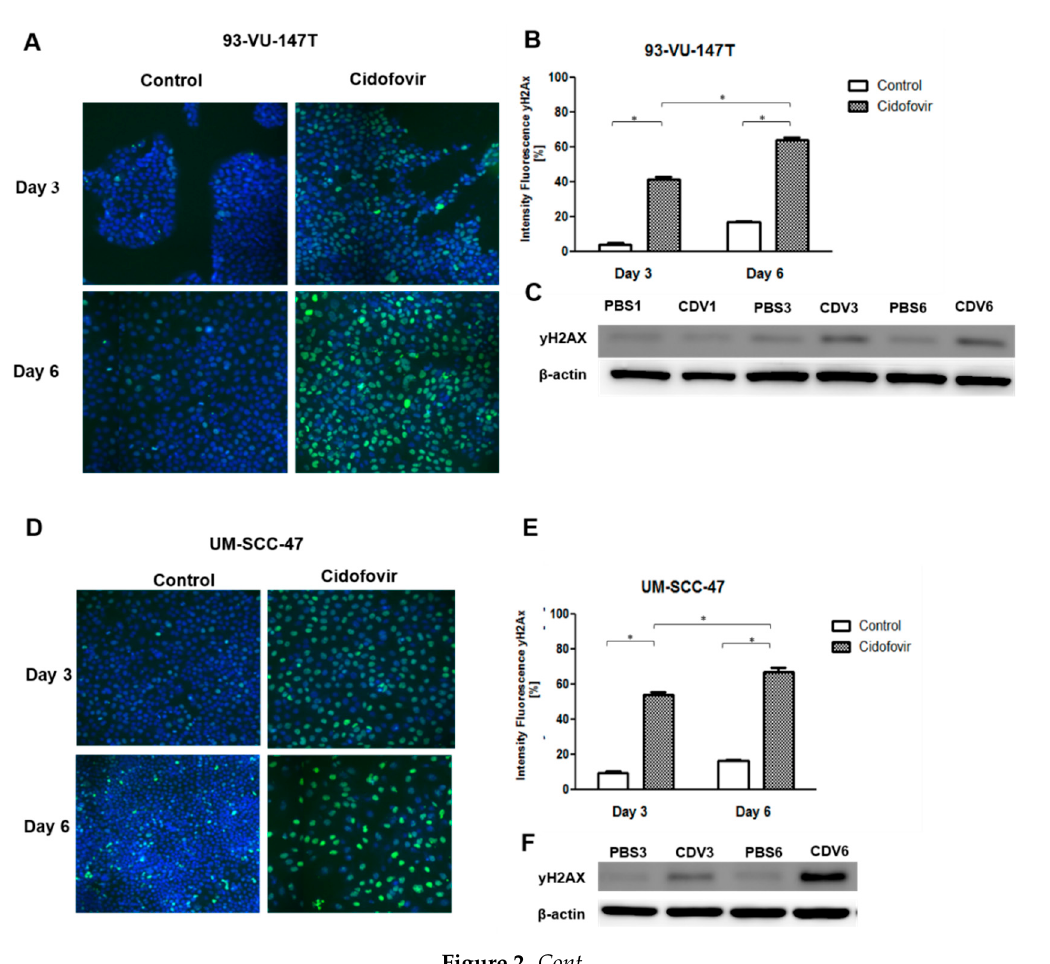
Figure 2. DNA damage induced by CDV as detected by γ -H2AX analysis. Cells were treated with CDV or PBS (control) and after 3 and 6 days immunostaining of γ -H2AX was performed. ( A ) DNA- damage is accumulated in the treated 93-VU-147T cells. Nuclei are stained with Hoechst in blue, DSBs are shown by γ -H2AX in green. ( B ) Quantification of γ -H2AX positive cells after 3 and 6 days CDV treatment. ( C ) Cell lysates of 93-VU-147T were examined by western blotting with p-H2AX after 3 and 6 days. β -actin was used as loading control. ( D ) DNA damage is accumulated in treated UM- SCC-47 cells. ( E , F ) Quantification of y-H2AX positive cells after 3 and 6 days CDV treatment and western blotting analysis of p-H2AX for UM-SCC-47, ( G , H ) UPCI-SCC-72, ( I , J ) and NOK. Statistical significance was indicated as follows: p < 0.05 (*). The experiments were performed in triplicate. 2.3. Activation of DNA Damage Response by CDV Since increased γ -H2AX expression upon CDV treatment suggests accumulation of DNA double strand breaks (DNA DSBs), the DNA damage response pathway was investigated at protein level. In response to DNA damage, cells normally activate the DNA damage response pathway, which causes